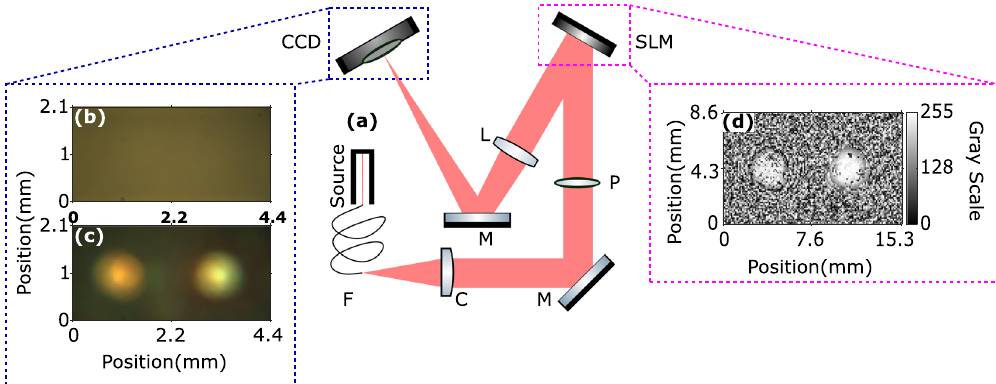
Figure 1. ( a ) The experimental setup that is used to emulate spectral splitters and concentrators: SpliCons using an SLM. Broadband light coming from the source coupled to the fiber (F) passes through condenser lens (C) ( f = 160 mm ) and linear polarizer (P) positioned on the way before SLM. A plano-convex lens (L) ( f = 300 mm ) is placed to transfer the image from the SLM surface onto the camera. ( b ) Image before optimization of the wavefront. ( c ) Spectrally split and concentrated light. ( d ) Phase pattern on the SLM that concentrates and spectrally splits light. The images ( b ) and ( c ) are raw images obtained from the CCD